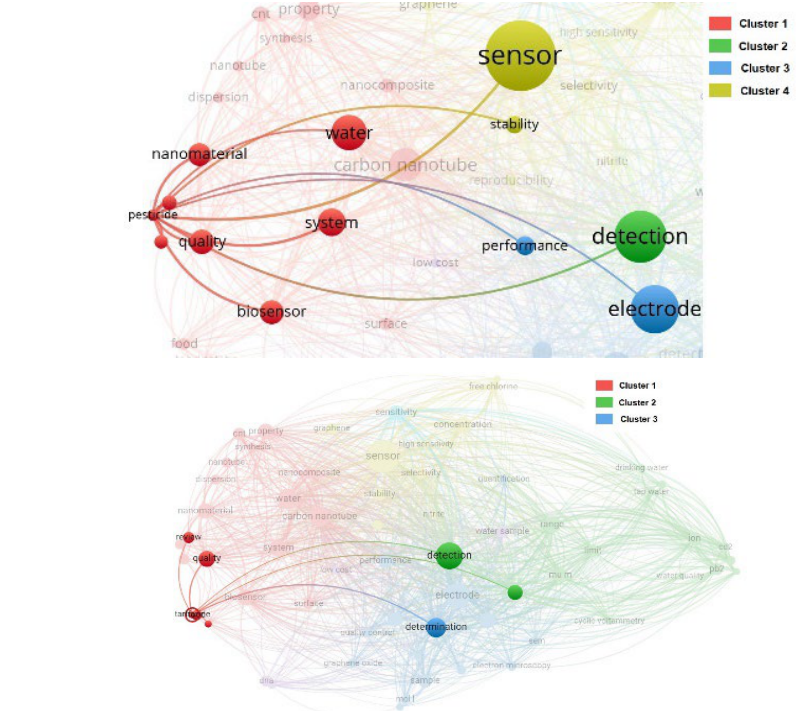
Figure 5. ( a ) Pesticide keyword network; ( b ) Tartrazine keyword network.